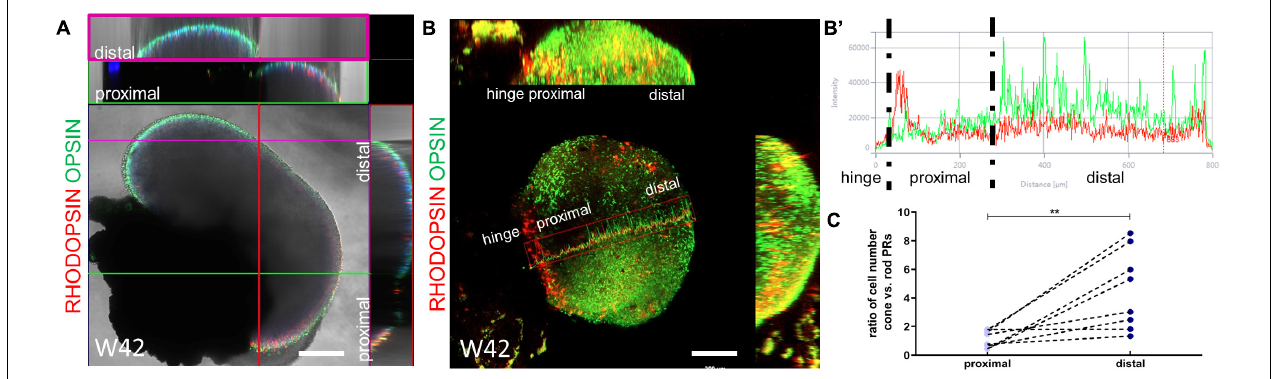
FIGURE 6 | The uneven distribution of rod and cone photoreceptor cells. (A) The ortho X-Z display of a random section of the organoid at Week 42 showed that the hinge distal part was mainly composed of cone PRs (Opsin B/G/R, green, purple frame) and rod PRs (Rhodopsin, red, green frame) mainly located at the hinge proximal part. (B) Ortho display of maximum intensity projection of the whole organoid at Week 42. The fluorescence intensity from the hinge proximal to distal part (marker by the red box) was calculated in (B’) . Scale bar = 200 µ m. (C) The ratio of the numbers of cone PRs versus rod PRs were paired calculated in the proximal and distal part, respectively. ** P <